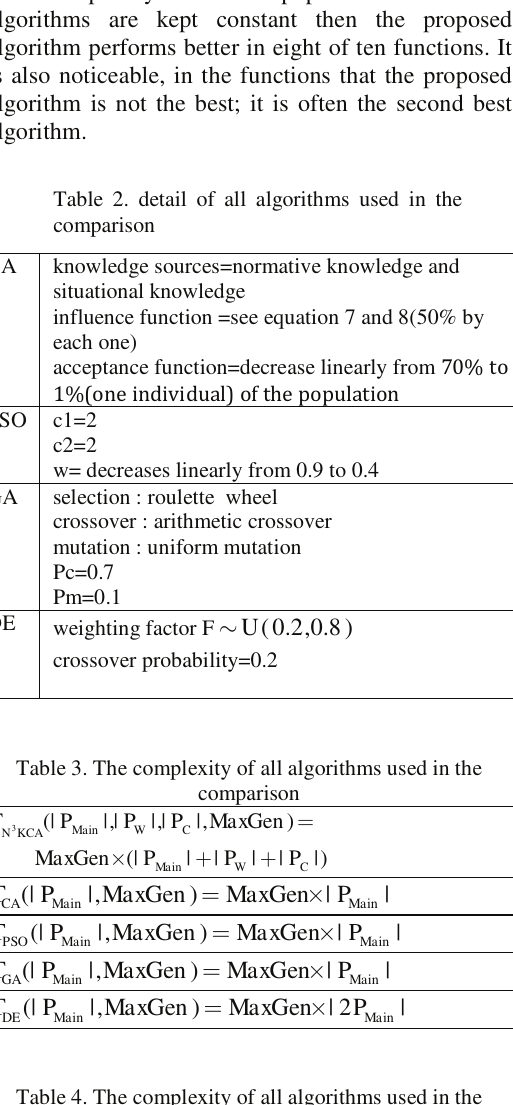
Table 4. The complexity of all algorithms used in the comparison. The sizes of all populations are kept